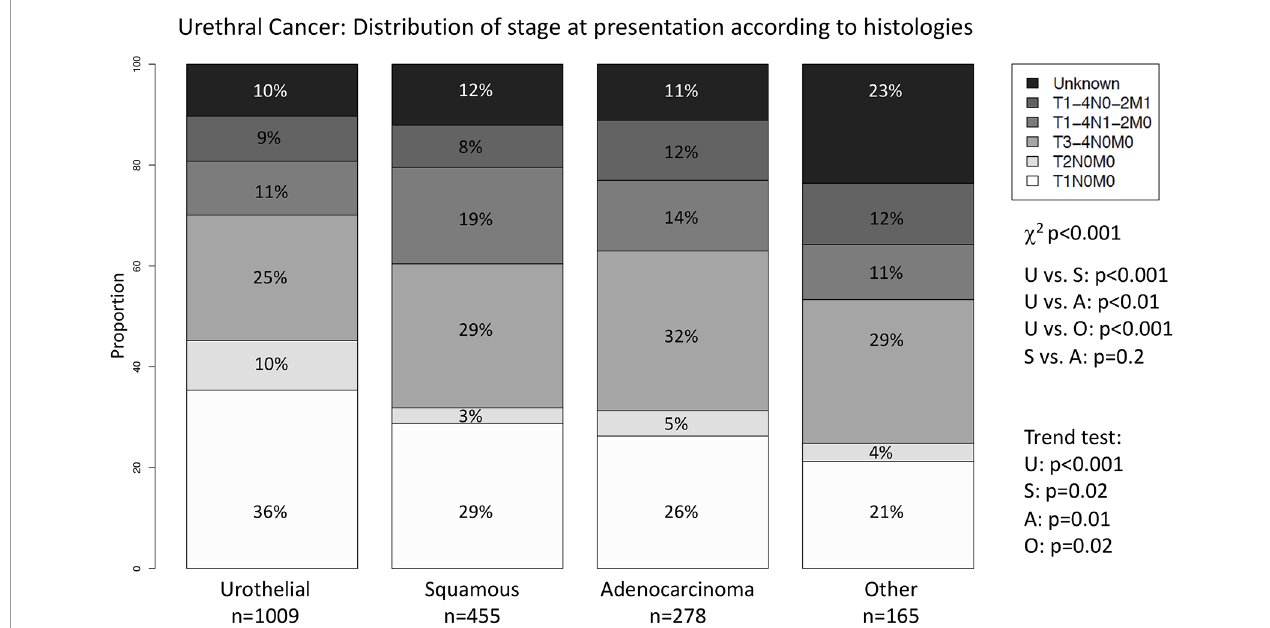
FIGURE 1 | Stage distribution according to histological subtype in urethral cancer. Stacked barplots depicting the stage at presentation according to histological subtype in 1,907 urethral cancer patients. U, Urothelial; S, Squamous Cell Carcinoma; A, Adenocarcinoma; O, Other; c 2 ,